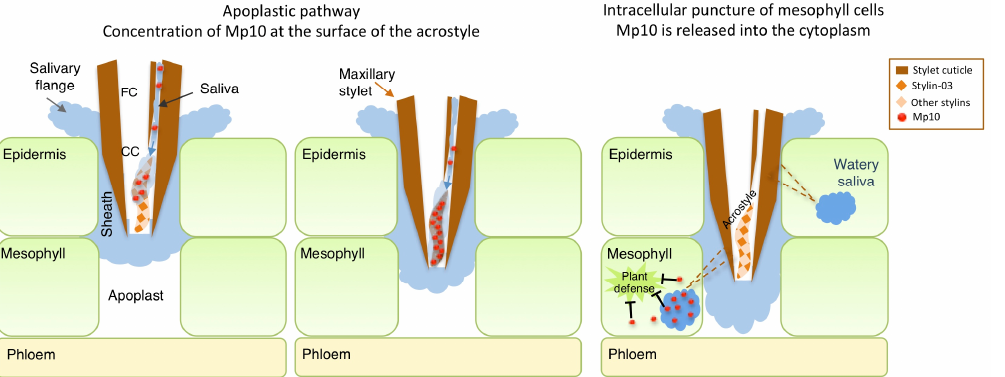
Figure 5. Model for the regulation of Mp10 delivery through acrostyle binding. One maxillary stylet tip inside plant tissue is represented in brown. The food canal (FC), common canal (CC) and acrostyle are indicated. During the apoplastic pathway, Mp10 (red dots) contained in gelling saliva (light blue) would bind to Stylin-03 (orange diamonds) at the surface of the acrostyle. While puncturing cells along the stylet track (pictured as brown dotted lines), watery saliva (dark blue) is secreted and flushed out. All of the Mp10 accumulated on the acrostyle would then be released in mesophyll cells where effector molecules can modulate plant responses.